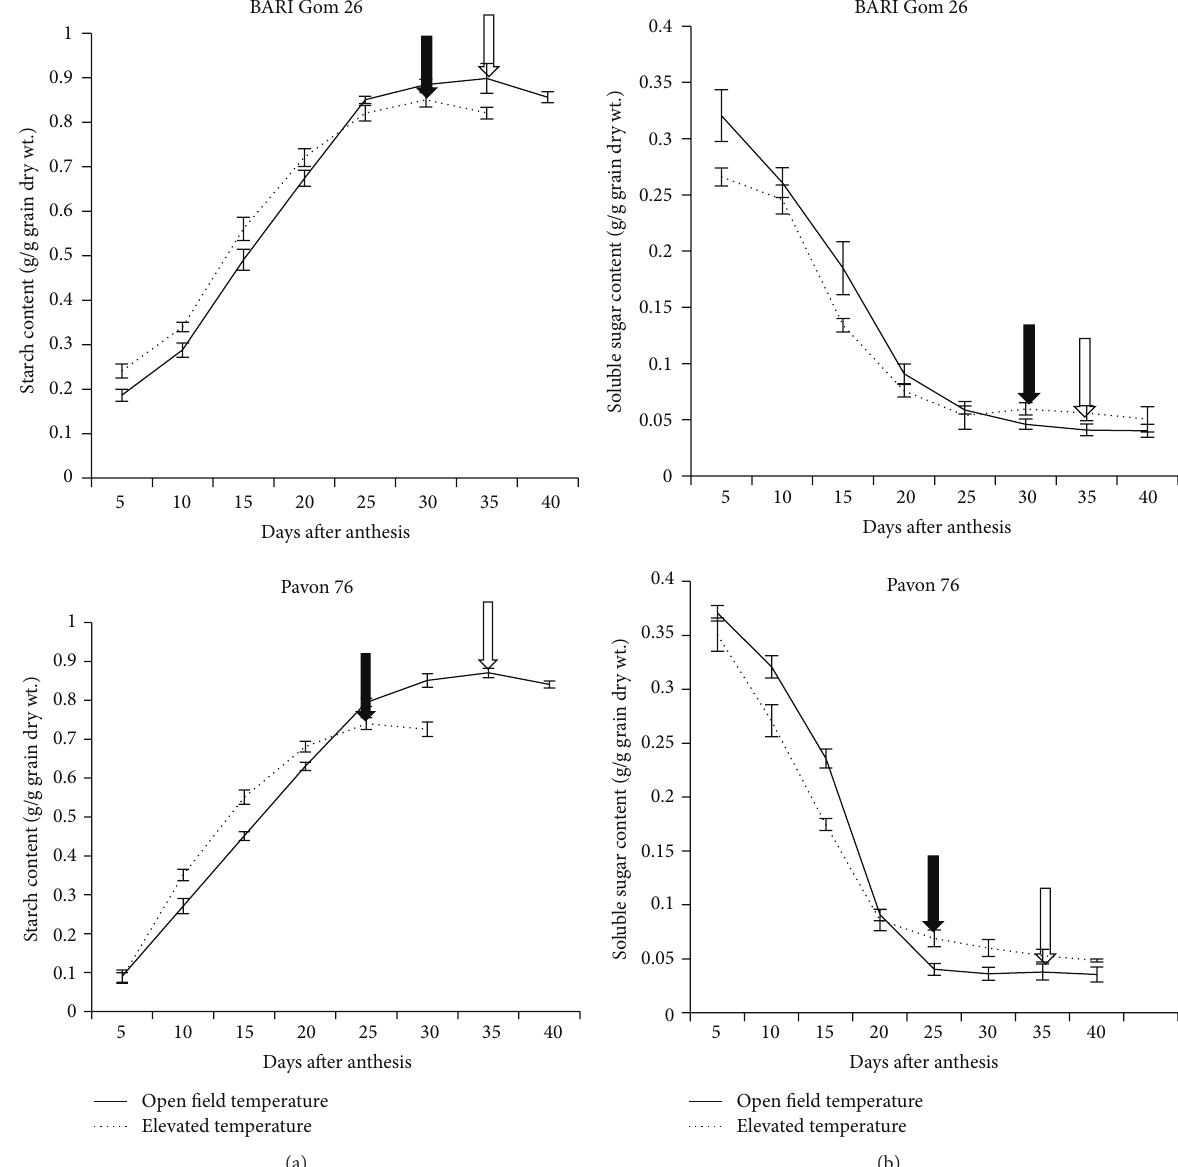
Figure 4: (a) Starch and (b) soluble sugar content in grain of two wheat cultivars from 5 DAA to maturity under open field and elevated temperature conditions. Unfilled and filled arrows indicate physiological maturity of wheat cultivars under open field and elevated tempera- ture conditions, respectively. Vertical lines are standard errors of selected data